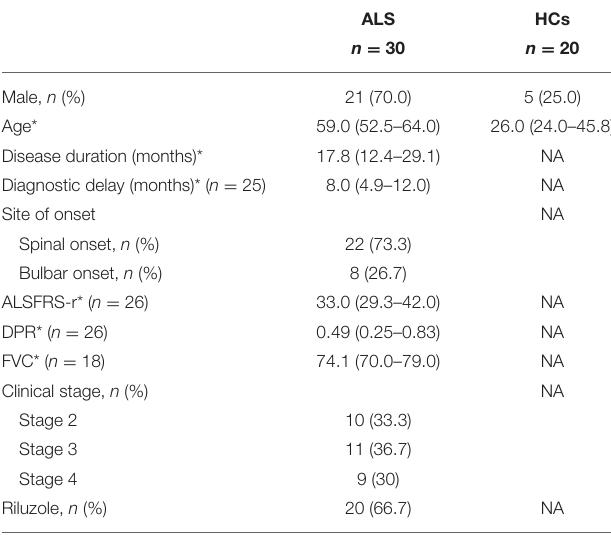
TABLE 1 | Clinical information of patients with ALS and HCs.